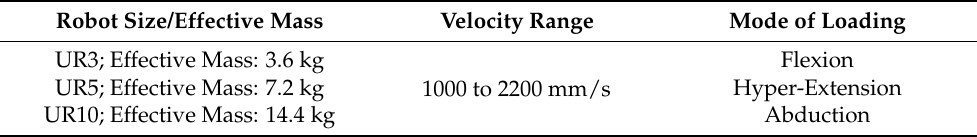
Table 2. Design of Virtual